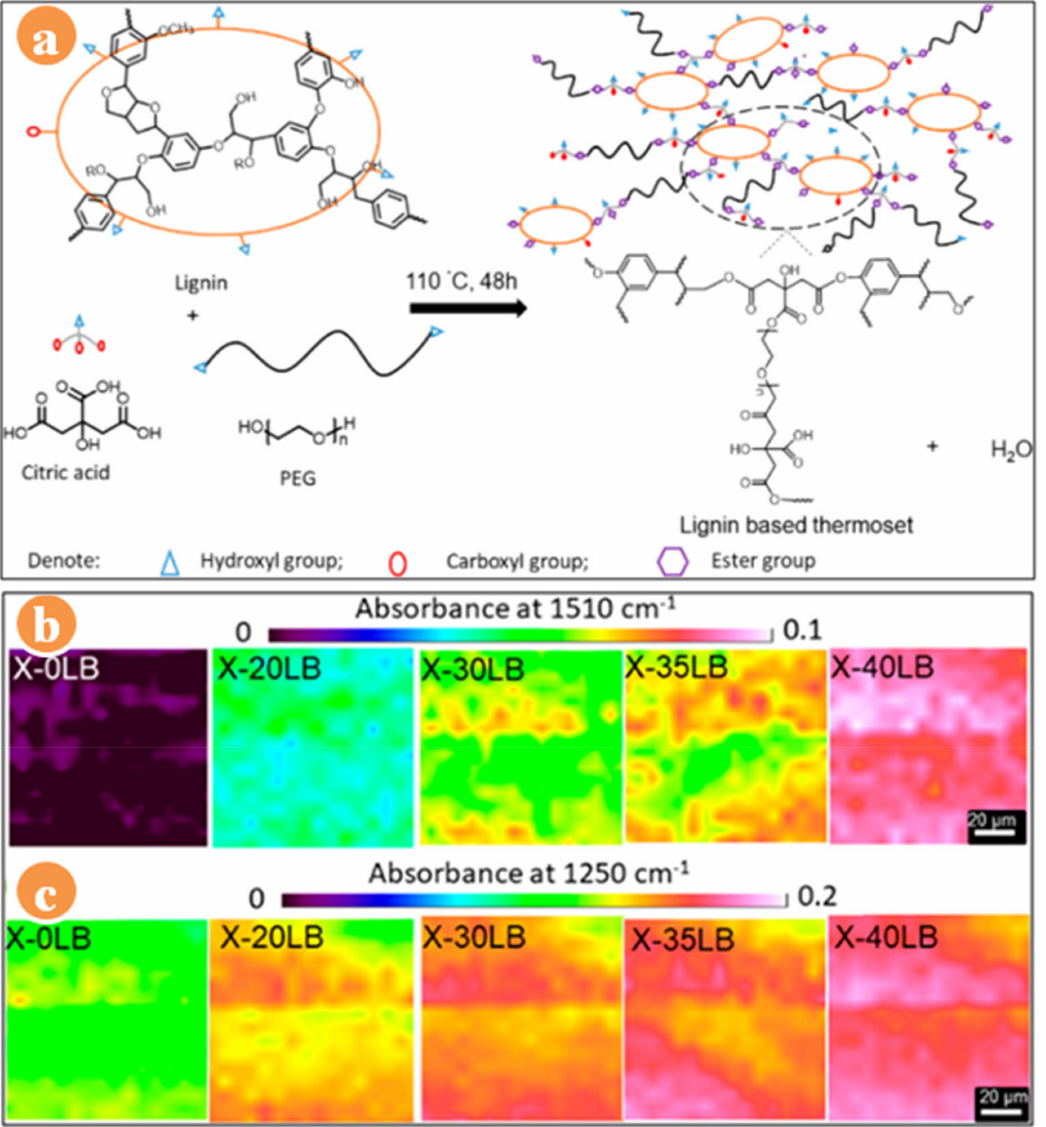
Figure 4. ( a ) Representative schematic crosslinking of lignin, ( b ) absorbance intensity patterns of aromatic content, and ( c ) ester bond